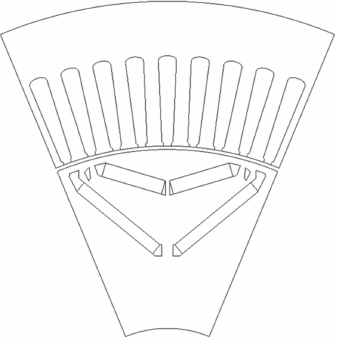
The topology and optimal design results are shown in Figures 15–17.